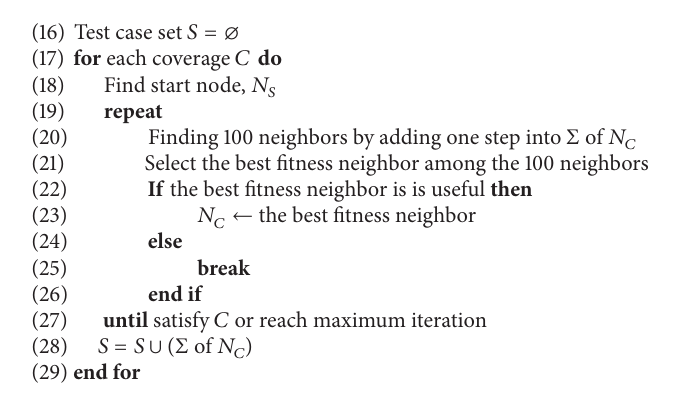
Algorithm 2: Pseudocode of local search algorithm.